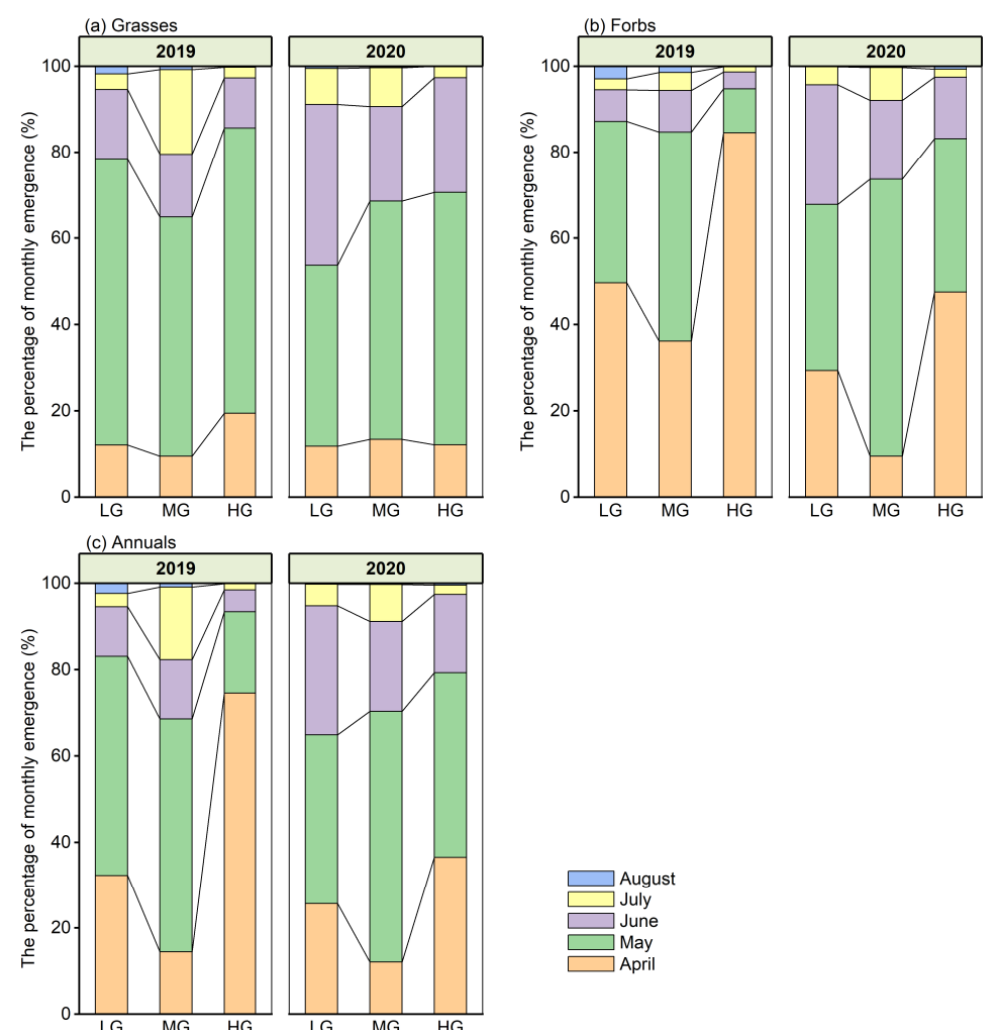
Figure 6. The percentage of monthly seedling emergence under the different grazing intensities during the two years. ( a ) annual grasses; ( b ) annual forbs; ( c ) all annuals.